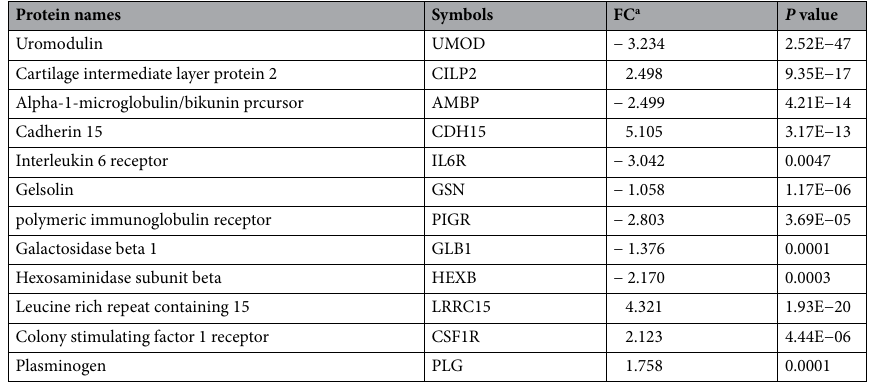
Table 1. Differentially expressed proteins in urine of adult (group A) compared to neonatal (group N) donkeys (A vs N) mentioned in this manuscript. a FC, fold change, a measure used to quantify the changes between urinary proteins in group N and group A. If the fold change value > 1.5, the number of proteins in group N is higher than in group A. if fold change value < 0.67, the number of proteins in group N is less than in group